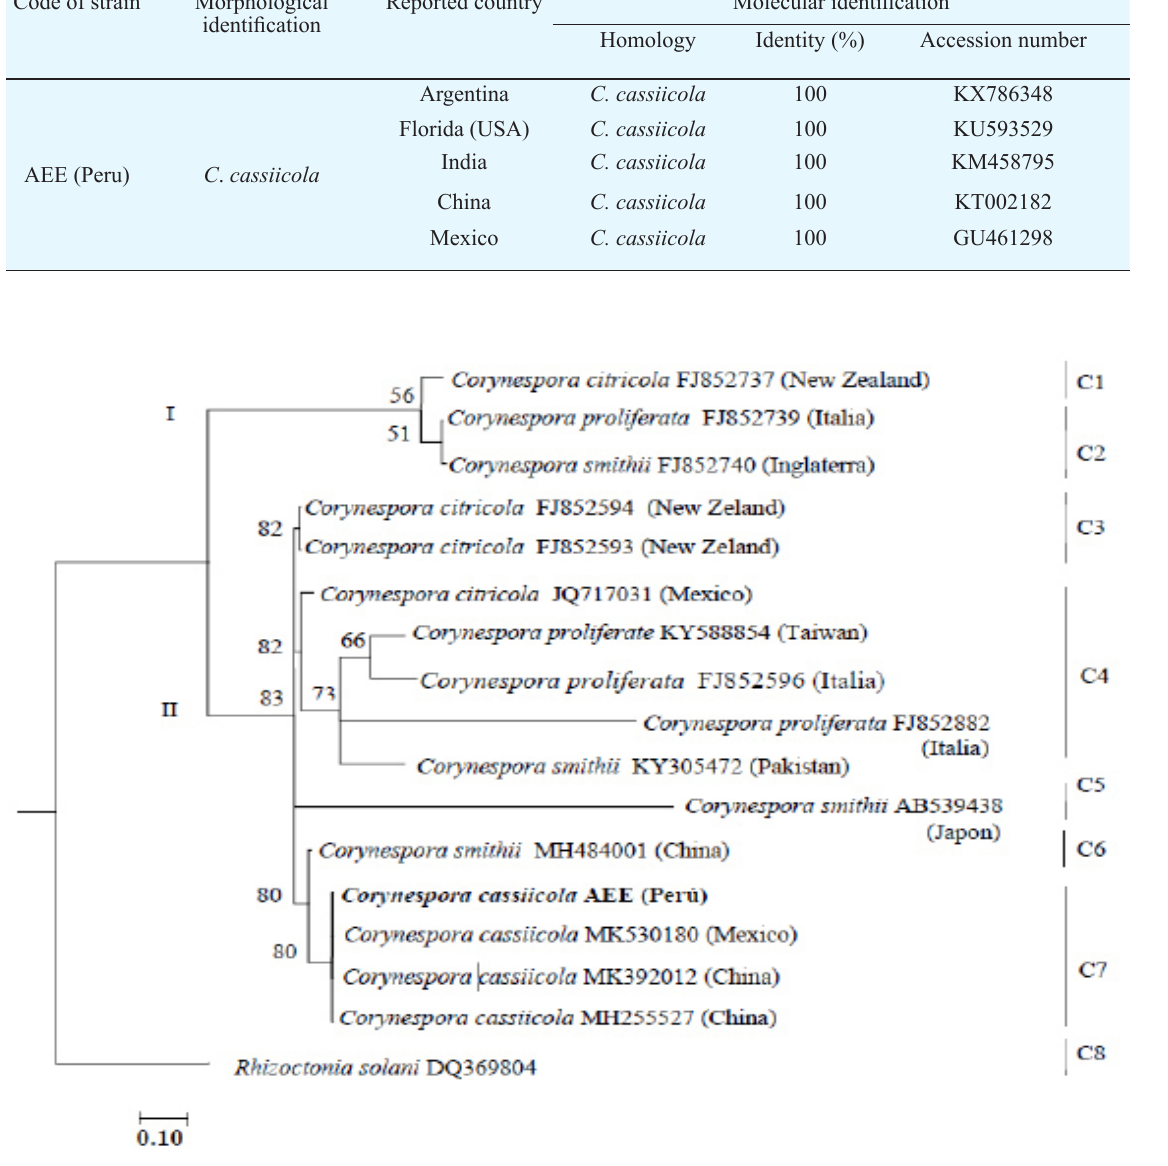
Figure 4. Phylogenetic tree constructed by Bayesian inference wherein it shows the relationships between the isolate under study Corynespora cassiicola AEE (Perú) and Corynespora cassiicola